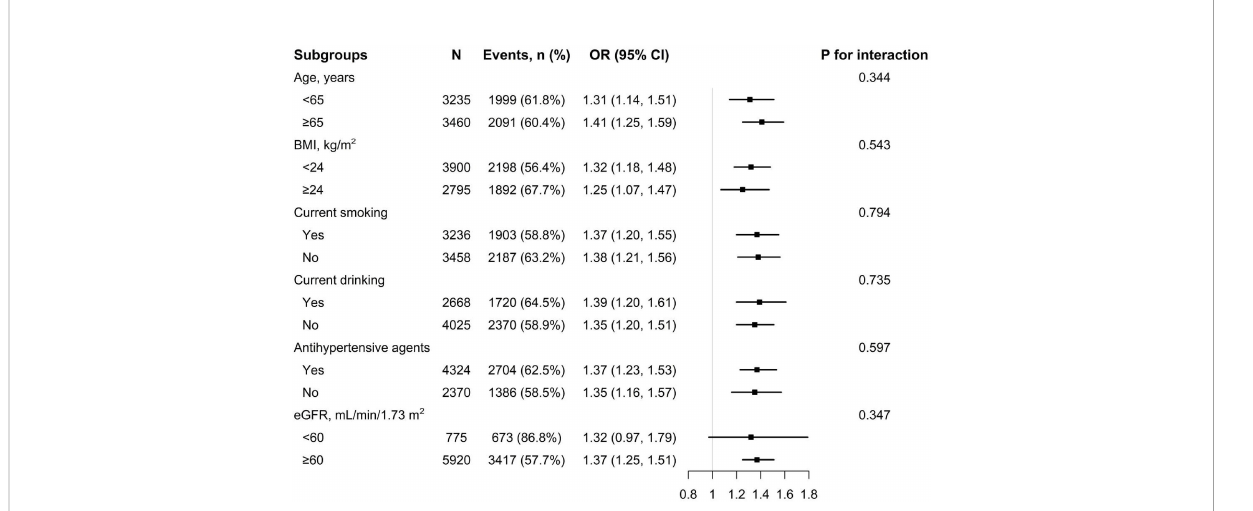
FIGURE 2 Subgroup analysis of the association between WWI and hyperuricemia among men. Each subgroup analysis is adjusted if not strati fi ed for age, heart rate, stroke, diabetes mellitus, coronary heart disease, current smoking, current drinking, antihypertensive drugs, lipid-lowering drugs,